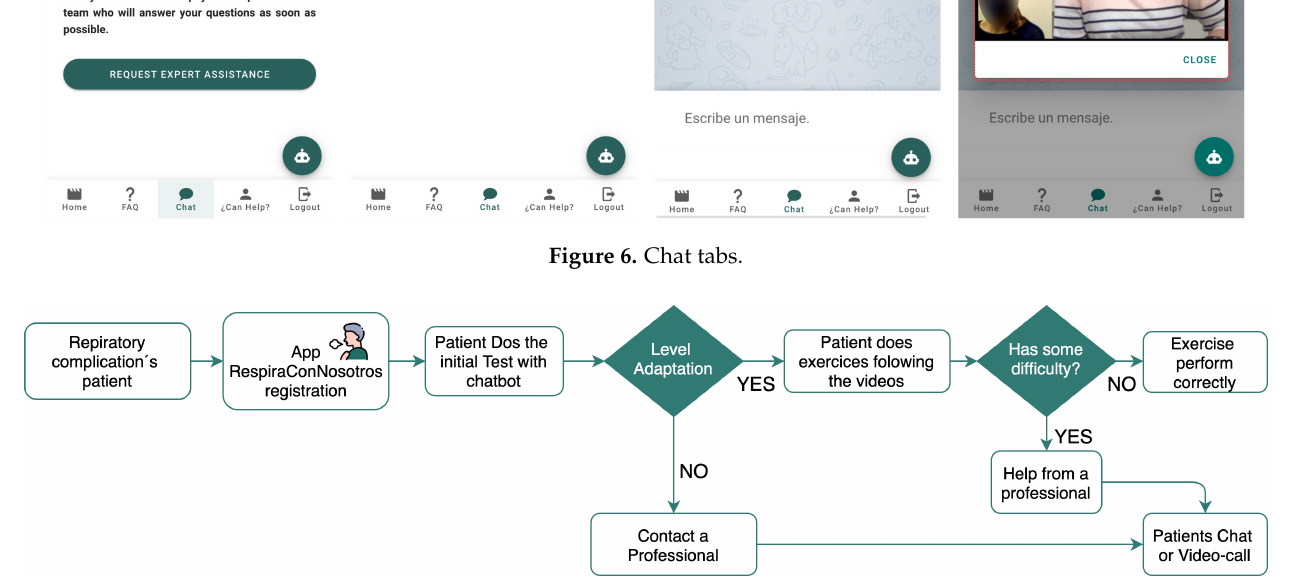
Figure 7. Diagram flow.